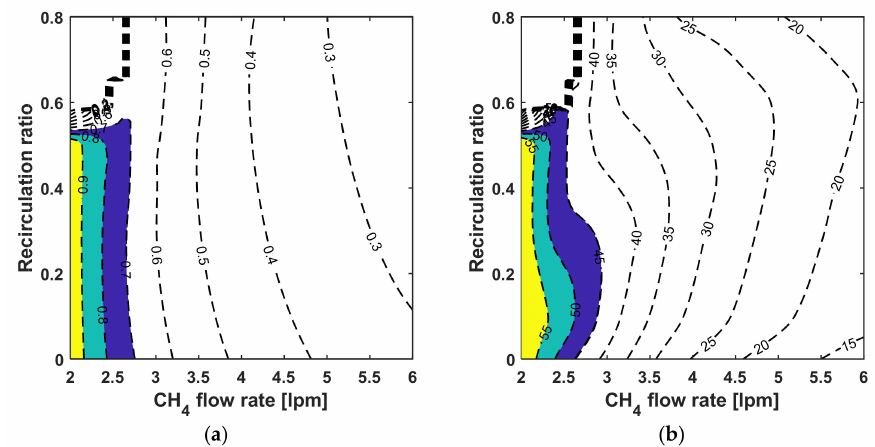
Figure 3. Changes of ( a ) fuel utilization factor ( U fuel ) and ( b ) electrical efficiency ( η elec ) with various fuel flow rates and recirculation ratios at current density of 0.3 A/cm 2 .